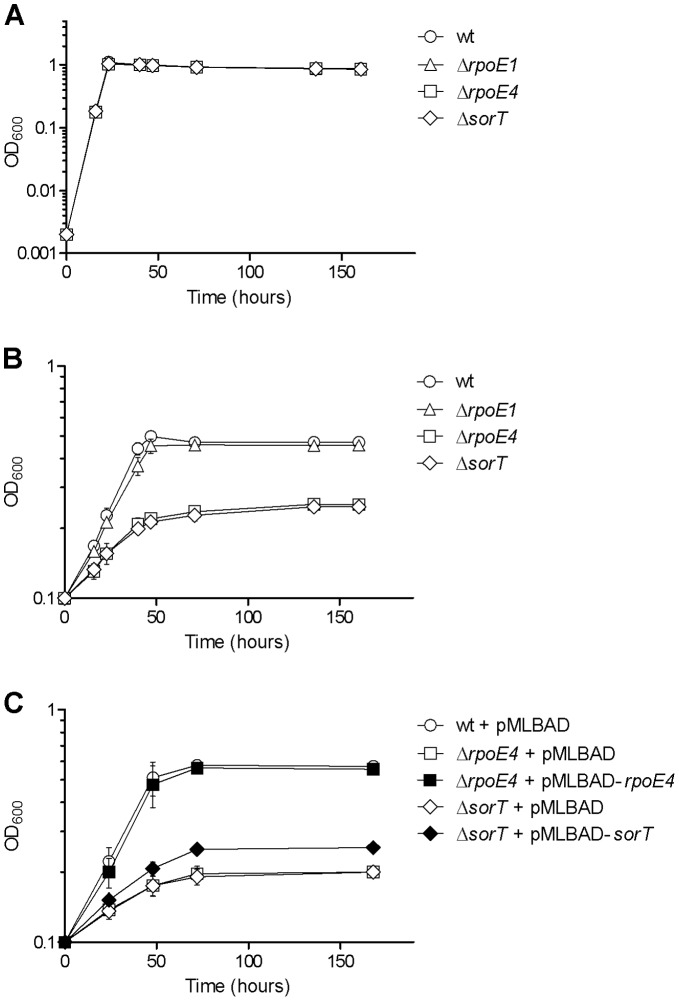
Growth curves of various S. meliloti strains, in the presence of succinate or taurine.Strains were cultured in Vincent minimal medium supplemented with either 10 mM sodium succinate (VMMS, A) or 100 mM taurine (VMMT, B and C) as sole carbone source. Strains GMI11495 (wt), CBT1022 (ΔrpoE1), CBT997 (ΔrpoE4), and CBT1267 (ΔsorT), carrying or not pMLBAD derivatives, as indicated, were pre-cultured to mid-log phase in VMMS, and were then either diluted in fresh VMMS to OD600 = 0.002 or centrifuged and resuspended in VMMT to OD600 = 0.1. Growth was monitored by measuring OD600 over several days. All media were supplemented with Sm, and with Tmp when strains contained pMLBAD derivatives (C). All strains carrying pMLBAD derivatives displayed similar growth curves in VMMS (not shown). The results shown are the means and standard errors of data from three independent experiments.